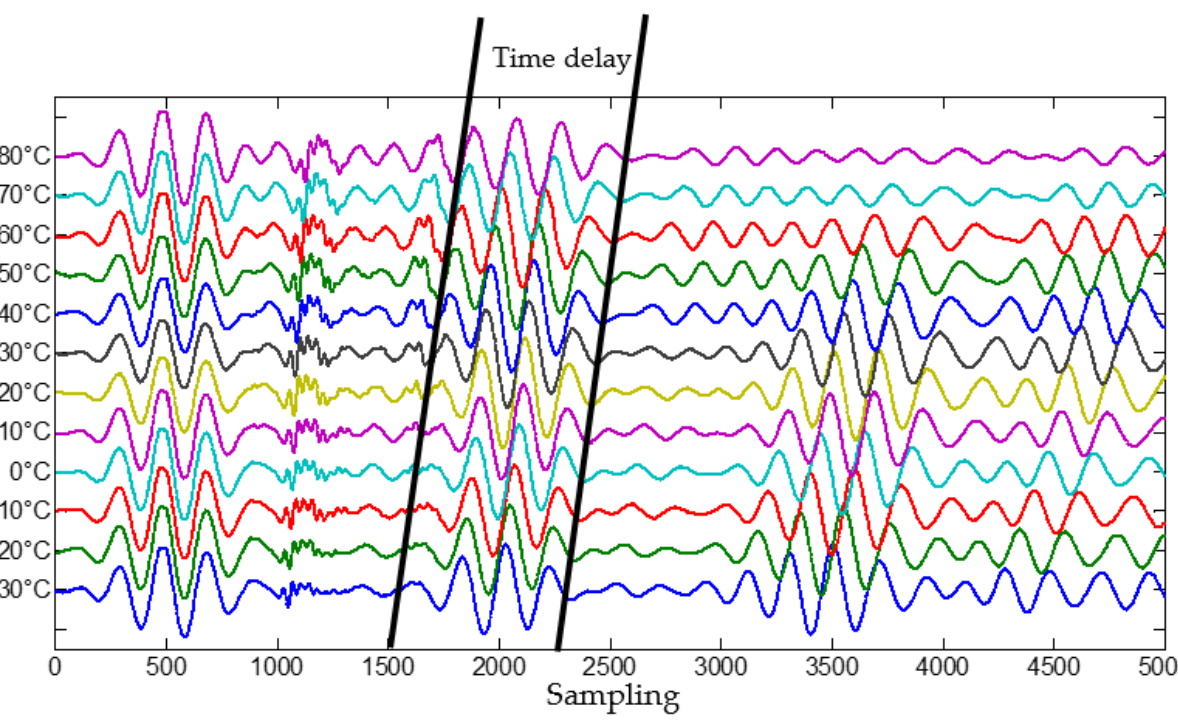
Figure 4. Experimental received Lamb wave array signal collection from −30° to 80°.